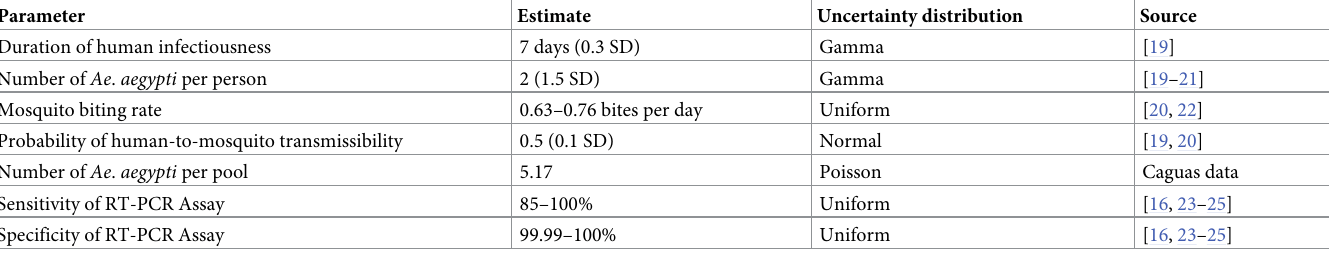
Table 1. Parameter assumptions for Aedes aegypti surveillance for Zika